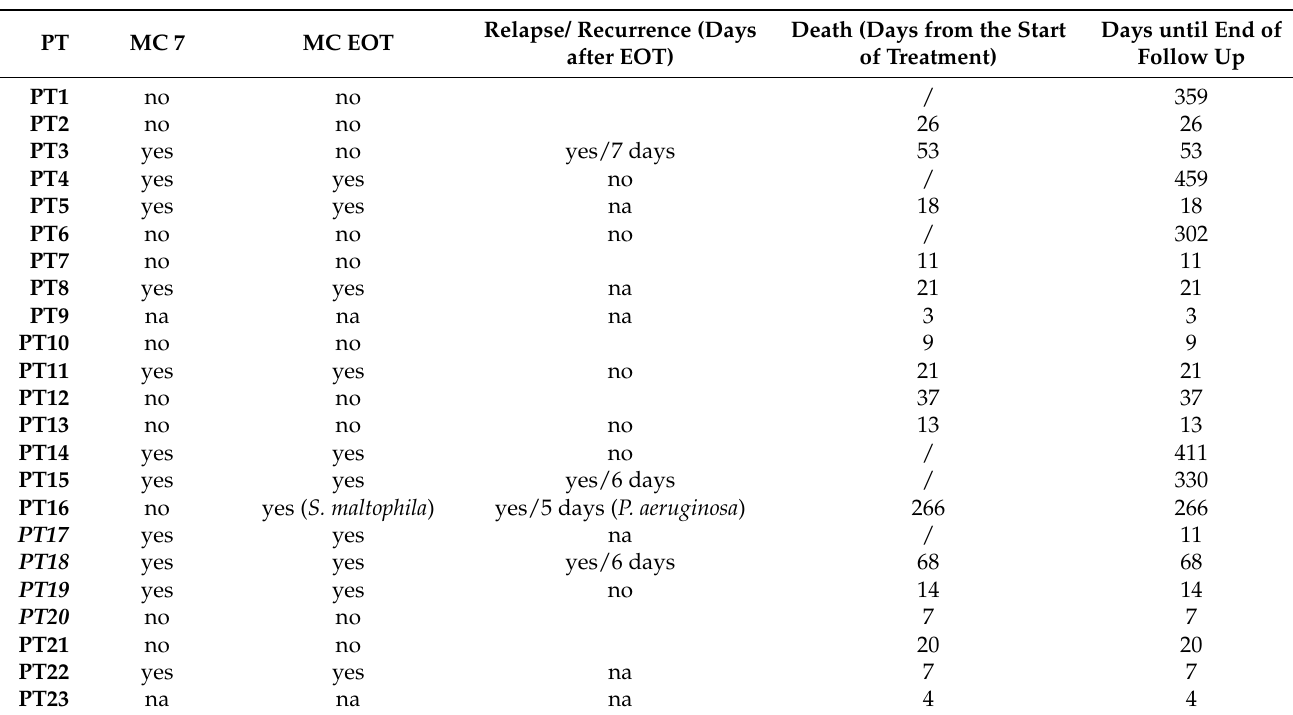
Table 3. Patient outcomes.